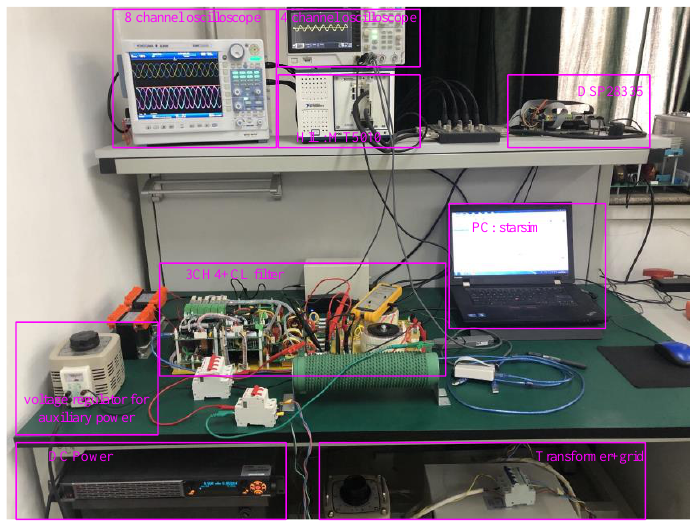
Figure 11. Experiment platform.